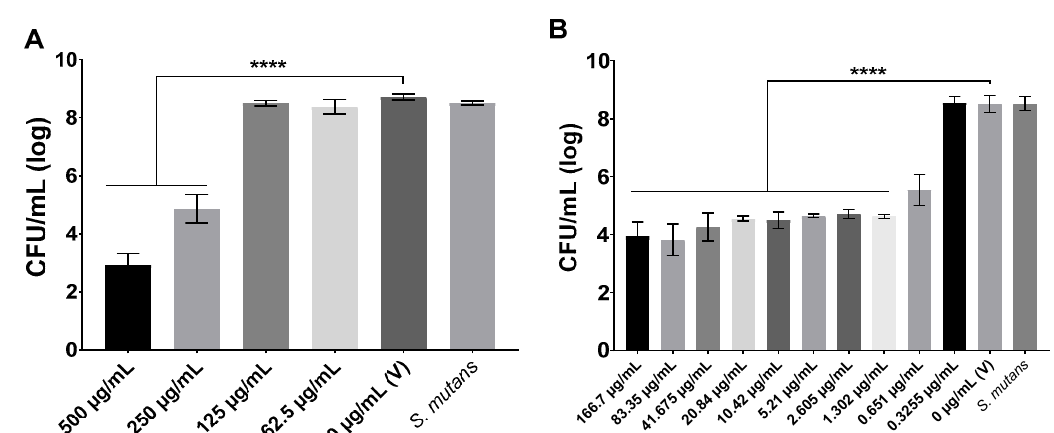
Figure 2. Antimicrobial activity of myricetin ( A ) and compound 1771 ( B ). The S. mutans viable population data are shown as average, and error bars correspond to the standard deviation (n = 12). V: Vehicle; for myricetin, the vehicle was 7% ethanol in 1xPBS (pH 7.2); while for compound 1771, it was 7% ethanol and 1.25% dimethyl sulfoxide (DMSO). S. mutans : growth control culture. **** denotes a statistically significant difference between the vehicle and the concentrations tested ( p < 0.0001; one-way ANOVA test, followed by Dunnett’s multiple comparisons test).